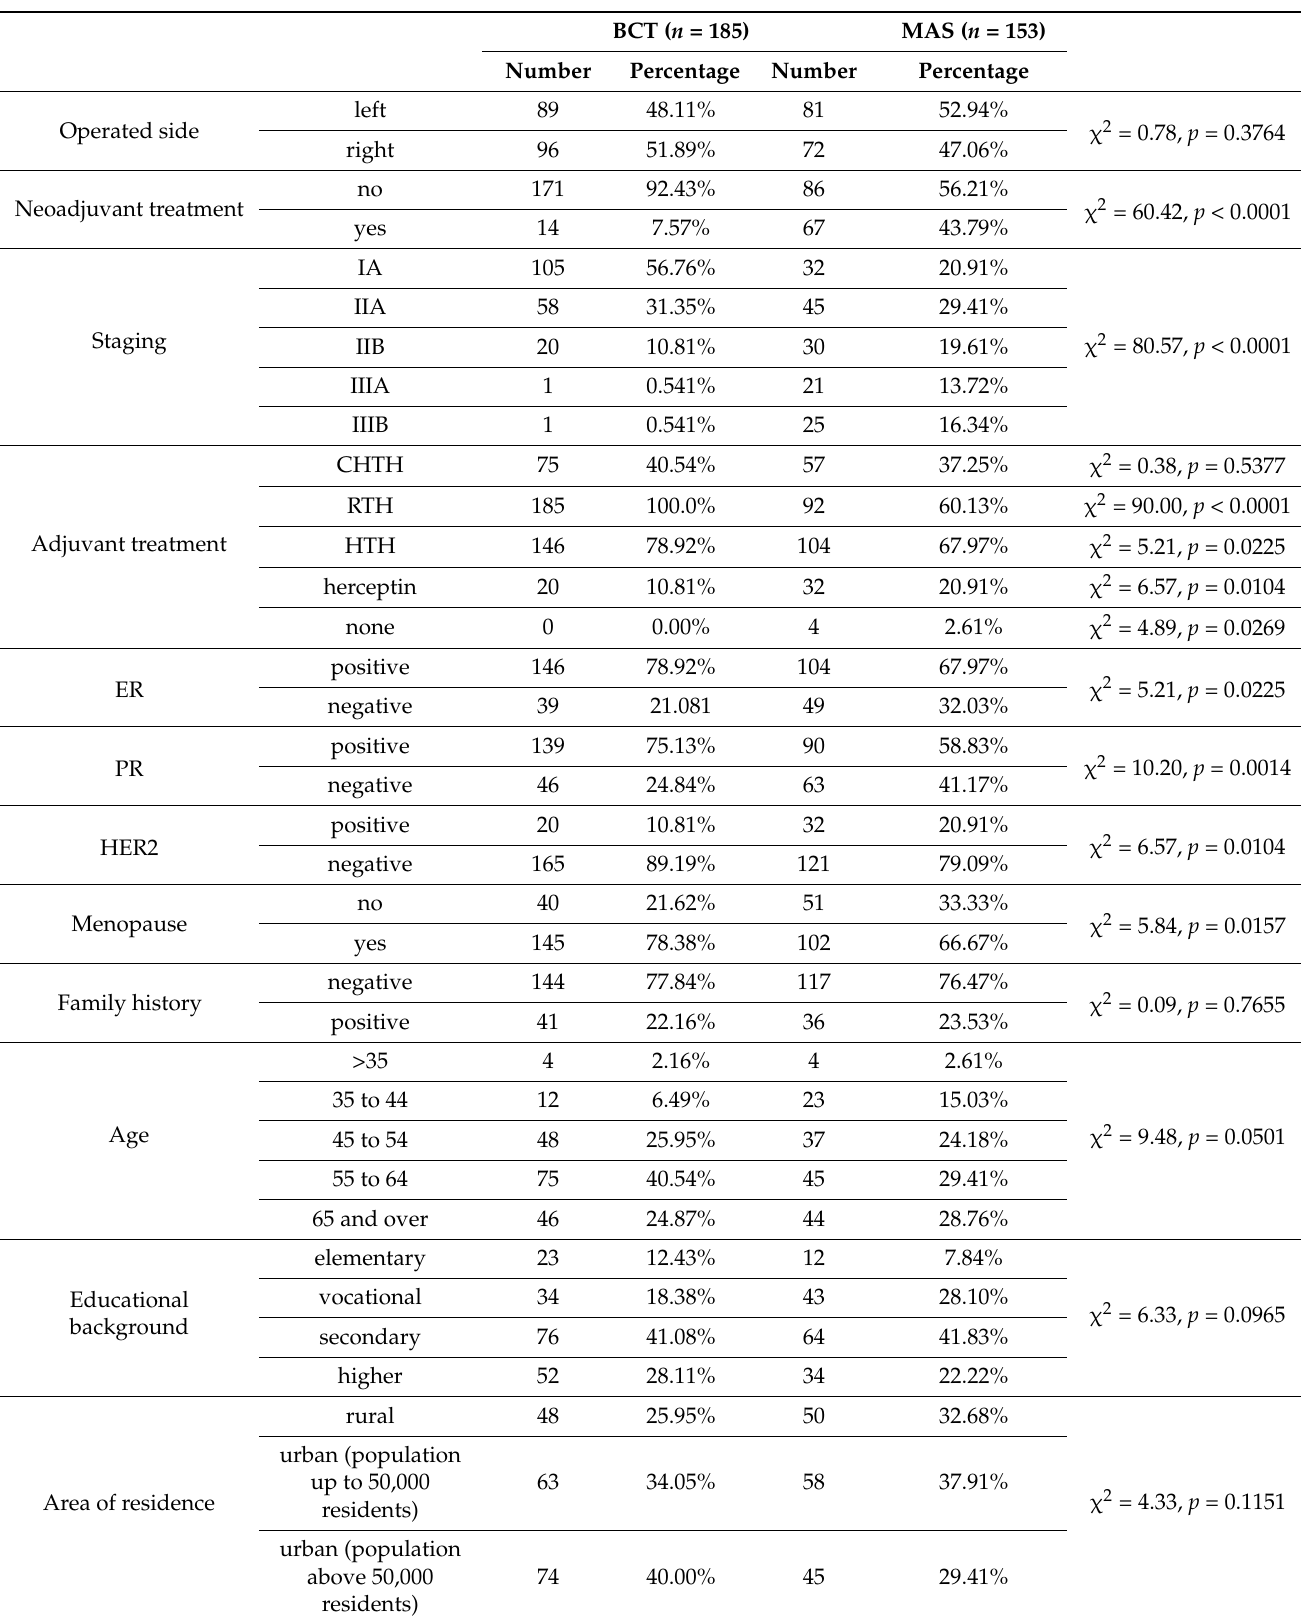
Table 1. Clinical and demographic characteristics of the study group (BCT vs.